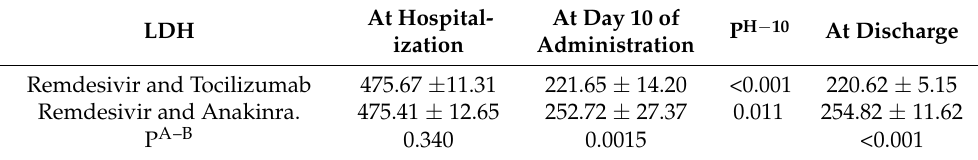
Table 6. Evaluation of LDH.